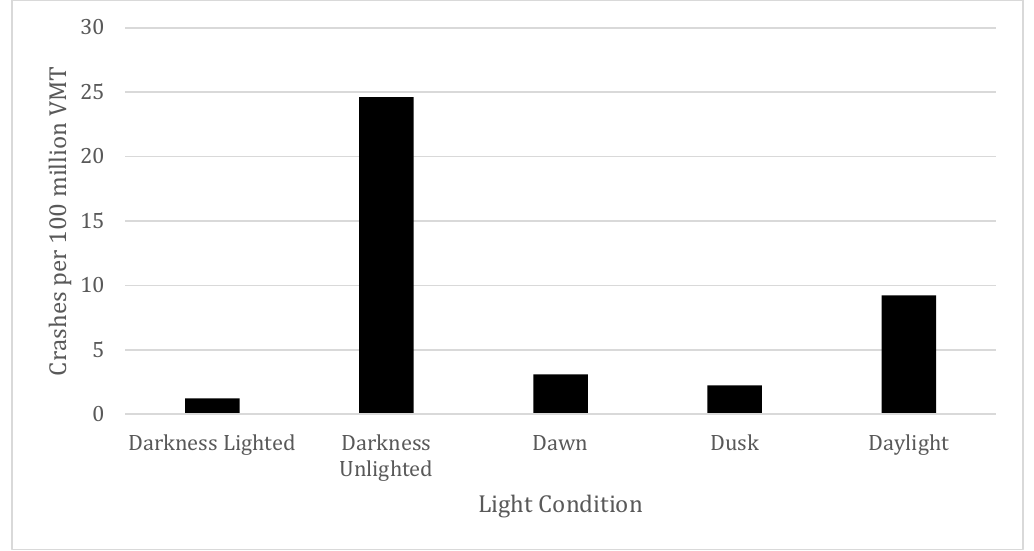
Figure 3 (e): Rate of animal-vehicle crashes occurring at different light condition